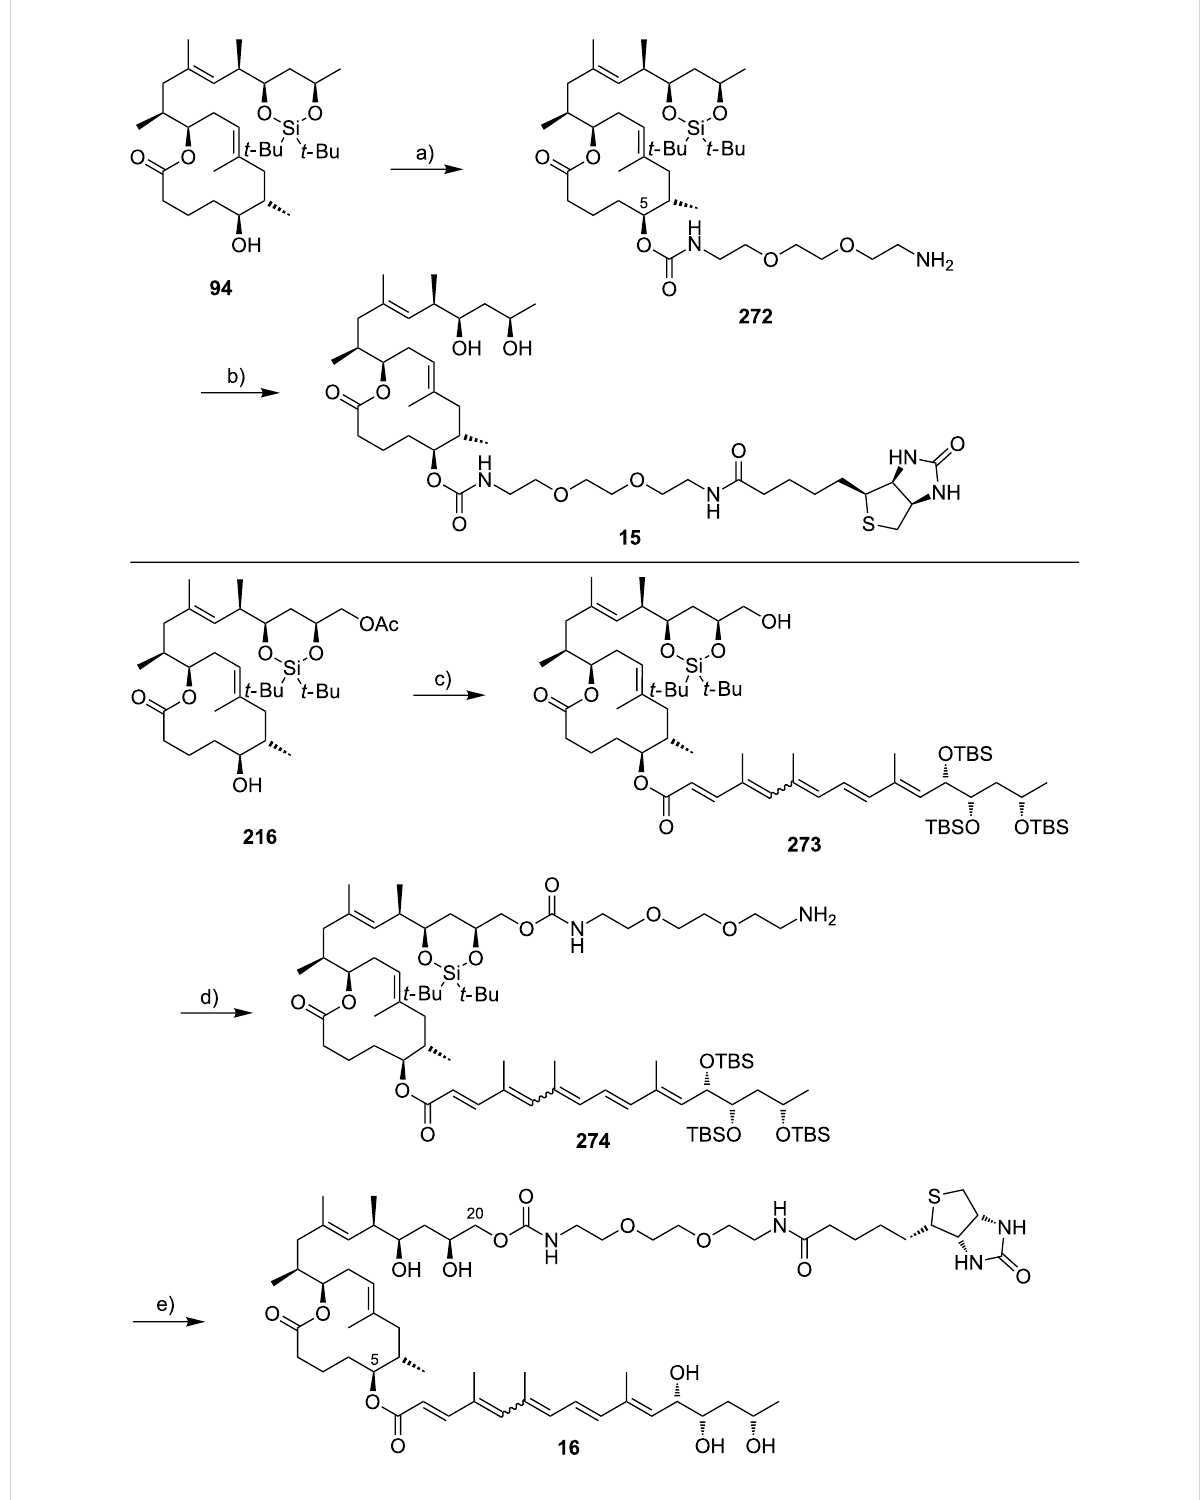
Scheme 45: Altmann’s synthesis of biotinylated mycolactones. Reagents and conditions: a) (i) CDI, THF, rt, 2 d, then H 2 O, rt, 45 min, then 1,2-bis(2- aminoethoxy)ethane, rt, 1 d, 81%; b) (i) HF·pyridine, THF/pyridine 4:1, rt, 2 h, 96%; (ii) (+)-biotin, PyBOP, DIPEA, DMF, rt, 30 min, 54%; c) (i) 122a,b , 2,4,6-trichlorobenzoyl chloride, DIPEA, DMAP, rt, 16 h, 88%; E - Δ 4’,5’ / Z - Δ 4’,5 ’ 4.3:1; (ii) K 2 CO 3 , MeOH, rt, 3 h, 90%; E - Δ 4’,5’ / Z - Δ 4’,5’ 4:1; d) (i) CDI, THF, rt, 5 h, then H 2 O, rt, 30 min, then 1,2-bis(2-aminoethoxy)ethane, rt, 90 min, 87%, E - Δ 4’,5’ / Z - Δ 4’,5’ 3:1; e) (i) TBAF, THF, rt, 4 h, then NH 4 F, rt, 17 h, quant., E - Δ 4’,5 ’/ Z - Δ 4’,5’ 3:1; (ii) (+)-biotin, DIPEA, PyBOP, DMF, rt, 30 min, 63% E - Δ 4’,5 ’ / Z - Δ 4’,5’ /other isomers